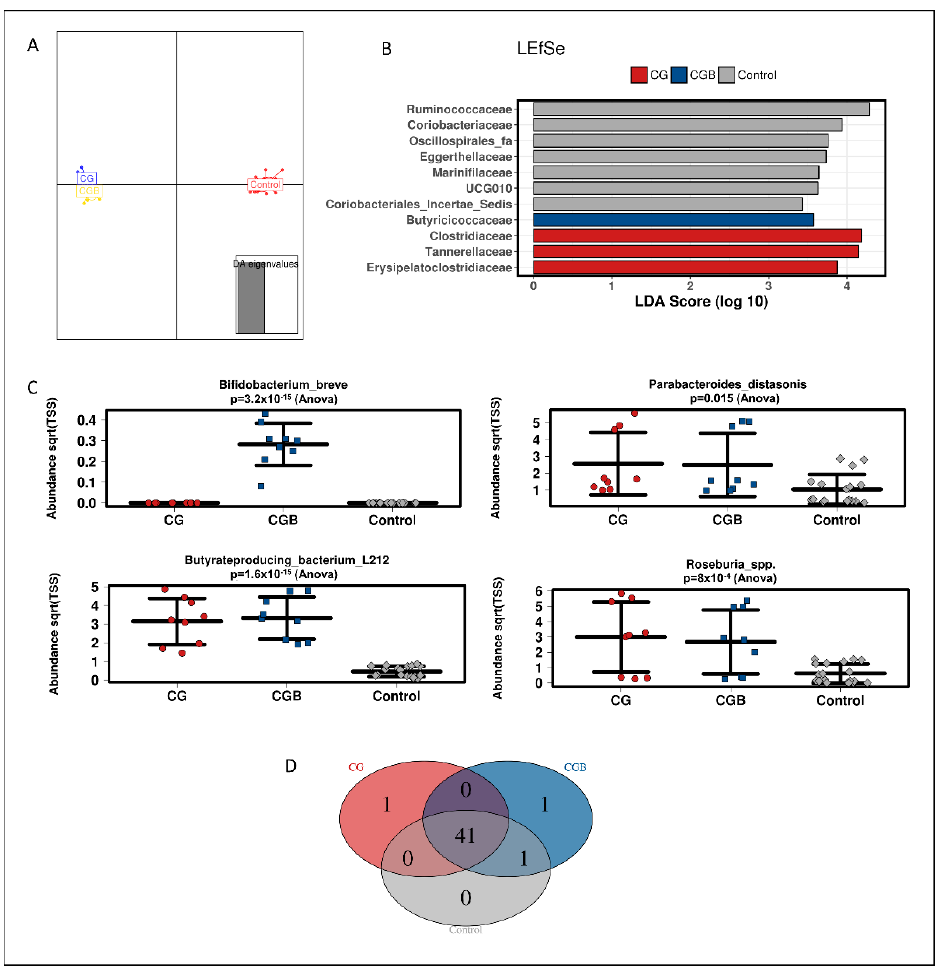
Figure 2. Effect of GC and GCB treatments on luminal microbial composition. ( A ) Discriminant analysis of principal components (DAPC) plot of the luminal compartment at family level; ( B ) linear discriminant analysis effect size (LEfSe) at family level; ( C ) strip charts of selected features at OTU level; ( D ) core microbiota at OTU level. Graphs represent 16S rRNA sequencing data from three healthy individuals (n = 3) in technical triplicates (N = 3).